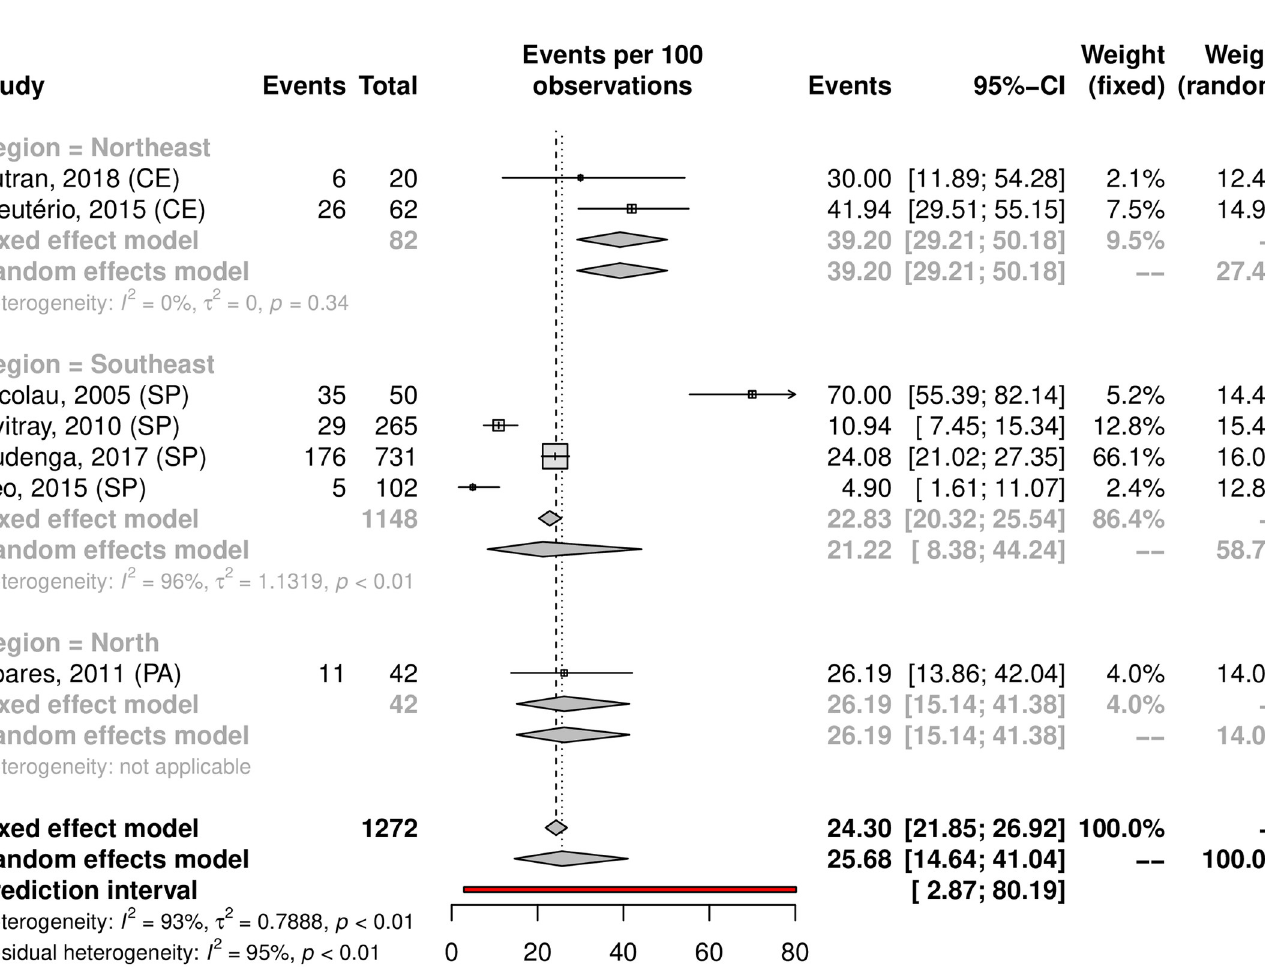
PLOS ONE | https://doi.org/10.1371/journal.pone.0229154 February 21, 2020 19 /